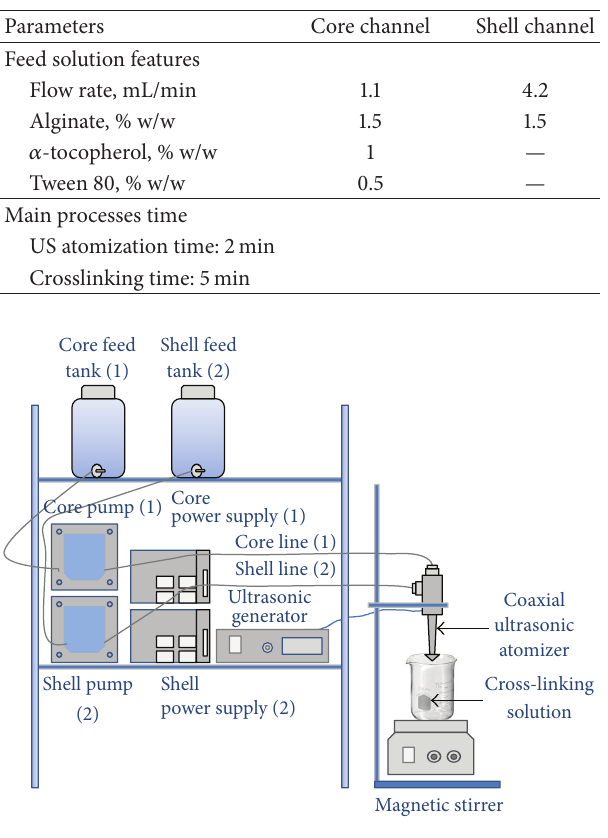
Figure 2: Sketch of the experimental set-up.